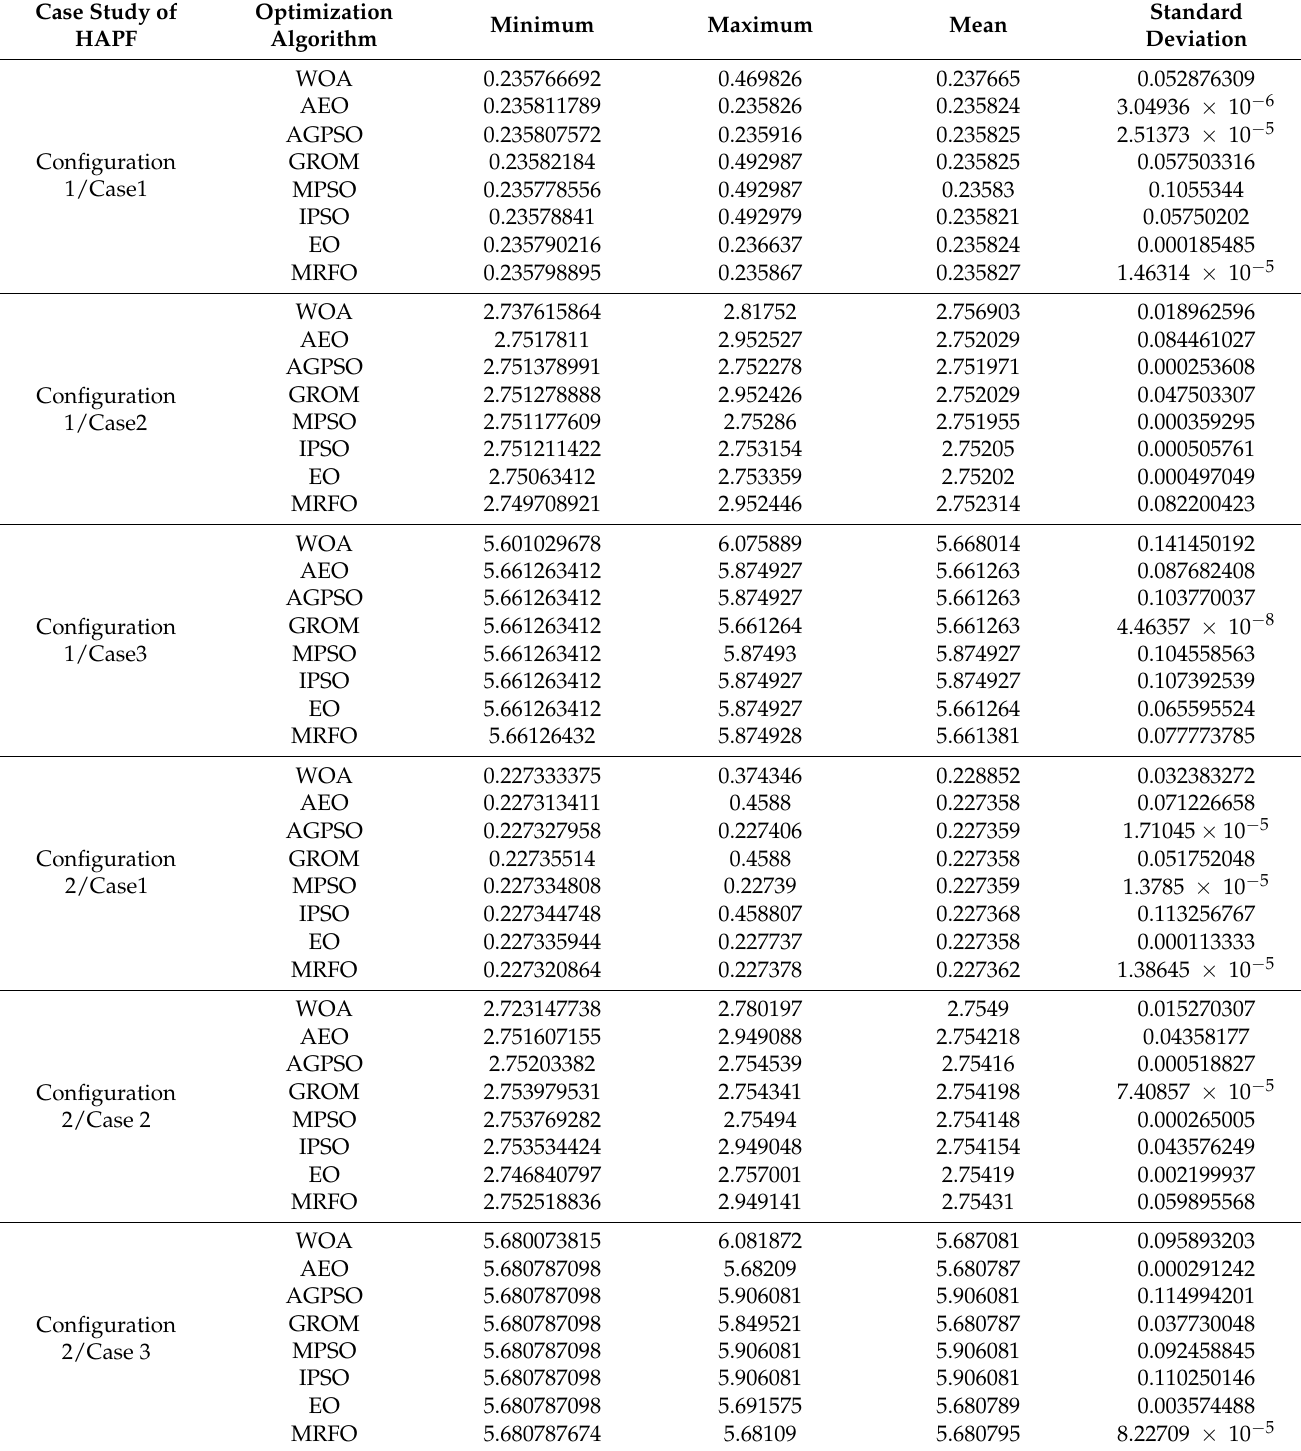
Table 6. The statistical analysis results of all optimization algorithms for the different HAPF